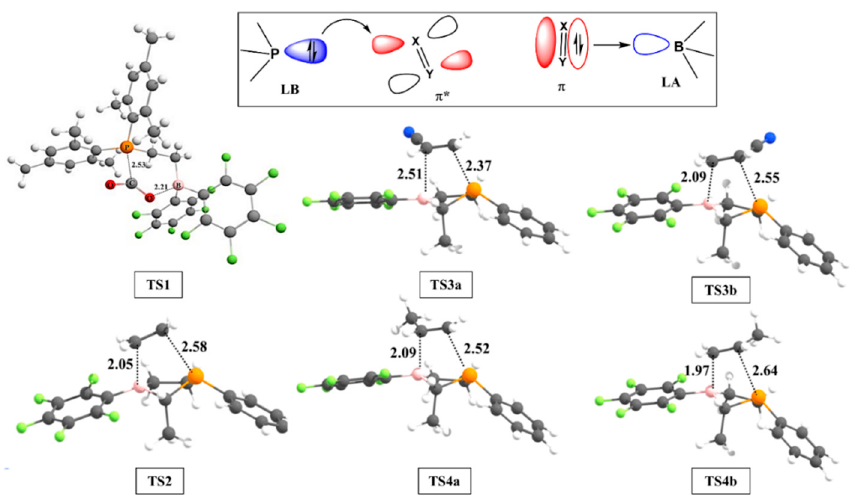
Figure 8. Schematic representation of activation of π -systems by FLPs, and optimized geometries of the transition states (TS) for the activations of CO 2 (TS1), ethylene (TS2), cyanoethylene (TS3a and TS3b), and propylene (TS4a and TS4b) with the P/B FLP. The bond distances are provided in Å unit. (Adapted from ref. [93] with permission from American Chemical Society. Copyright © 2022, American Chemical Society).